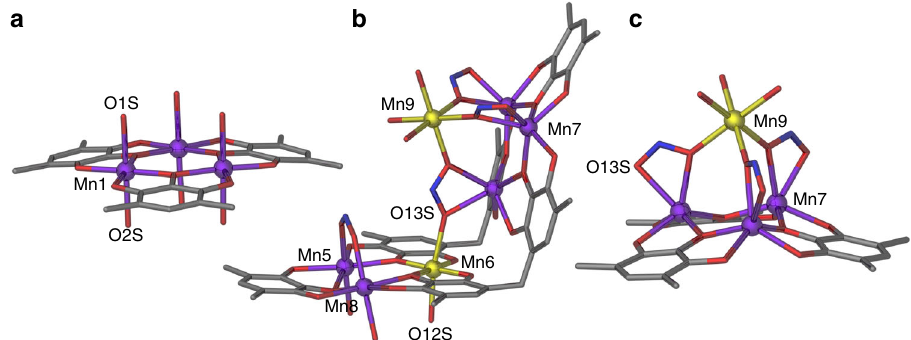
Fig. 2 Sections of 1 showing the disparate Mn coordination sites. a Distorted octahedral geometry around Mn II ions. b Linkage of Mn III ions in the structure through µ 3 -nitrite anions. c Anchoring of Mn9 to Mn7/Mn7 s.e. facet. Disordered PgC 5 alkyl chains and H atoms have been removed for clarity.